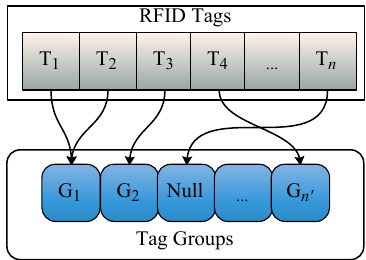
Figure 3. The structure of the inverted index for Radio Frequency Identification (RFID)